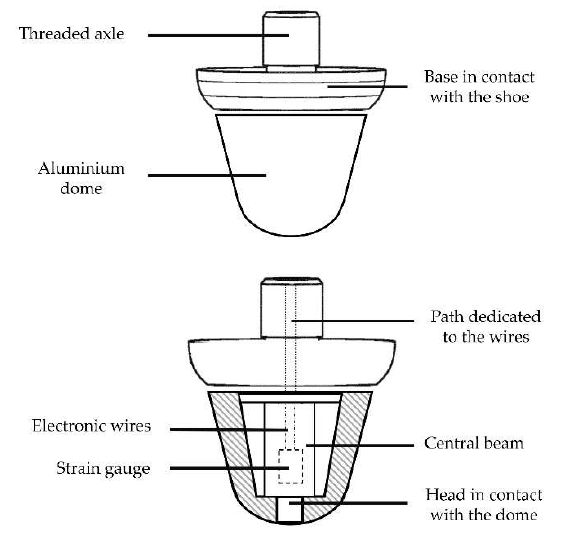
Figure 1. Instrumented stud representation (adapted from Labbé et al., 2018